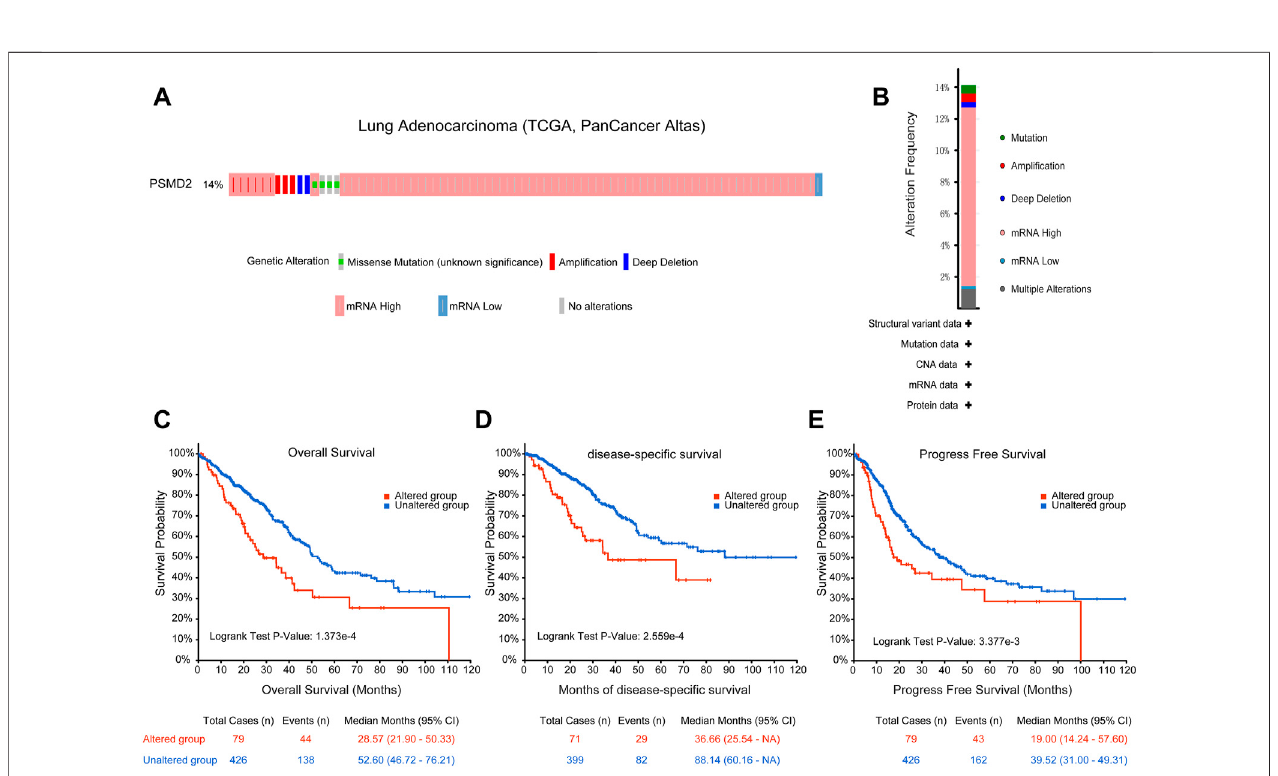
FIGURE 6 | Genomic mutation of PSMD2 in lung adenocarcinoma. (A) OncoPrint presented the different mutation types and proportions of PSMD2 . (B) Cancer types summary showed the alteration frequency. (C – E) Genomic mutation of PSMD2 was correlated with poor overall survival, disease-speci fi c survival, and progression-free